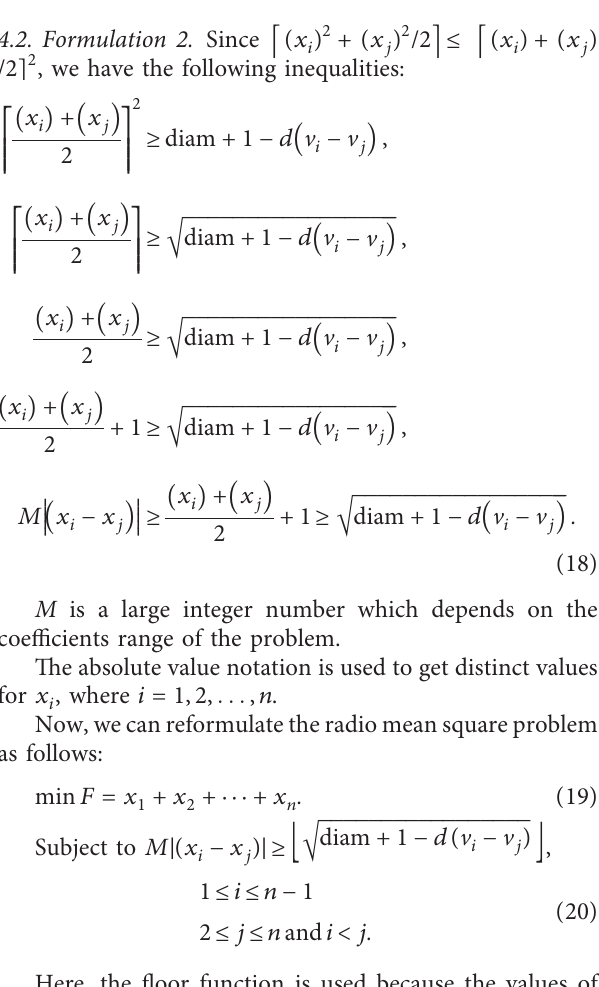
,C ,C , and C . (a) rmsn( C 16 ) � 17. (b) rmsn( C 17 ) � 18. (c) rmsn( C 95 ) � 8 9 16 17